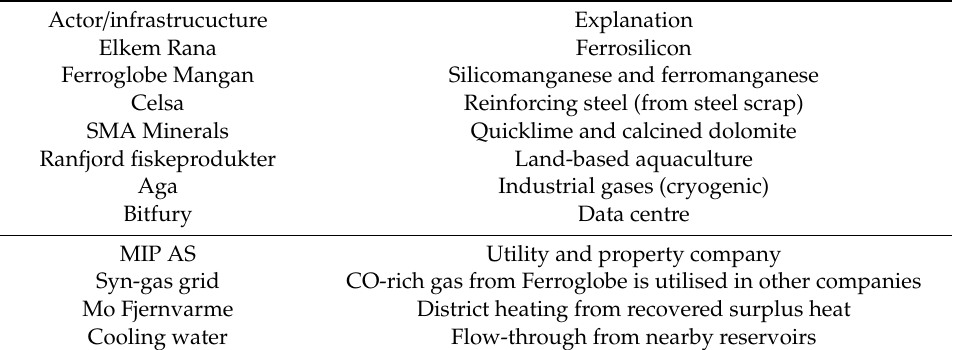
Table 1. Relevant actors and key infrastructure in Mo Industrial Park.